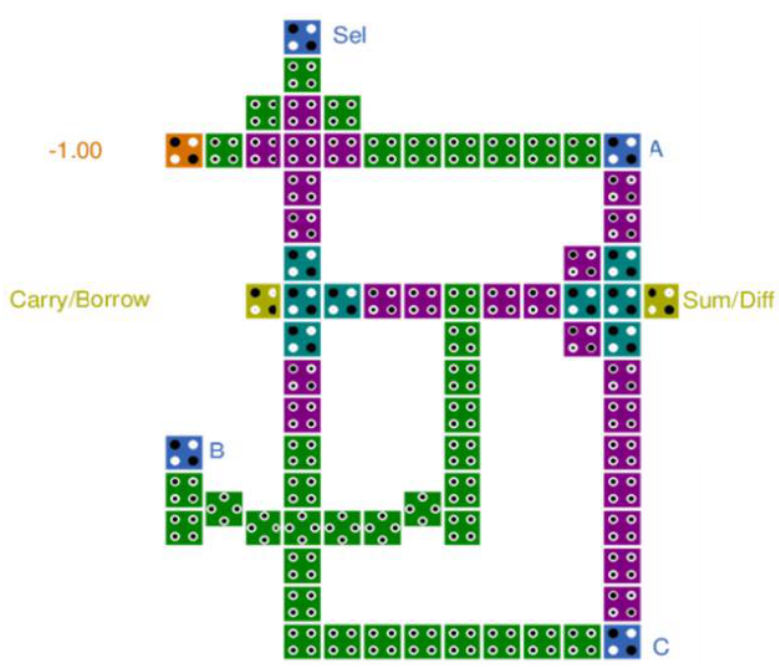
Figure 9. Full Adder/Full Subtractor circuit [16].